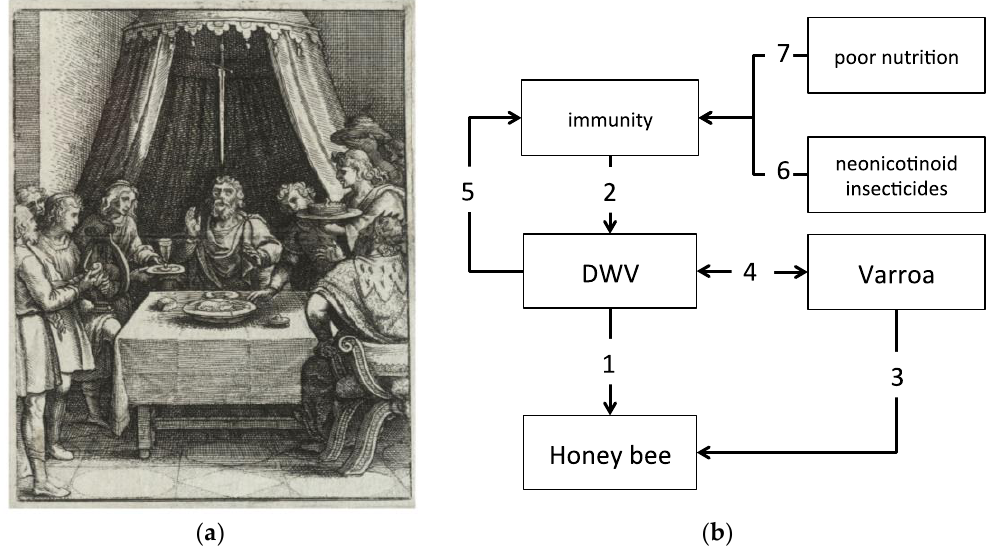
Figure 1. The expression ‘ sword of Damocles ’ denotes the sense of foreboding engendered by a precarious situation, whereby the onset of tragedy is restrained only by a delicate trigger. ( a ) A pictorial representation of the legend that generated the colloquial expression, by Wenceslaus Hollar (1607–1677), where the sword hanging above Damocles neck is depicted; ( b ) Honey bees are permanently threatened by covert DWV infections (1) that are normally kept under control by the bee’s immune system (2); the Varroa mite, which also causes direct damage to bees (3), can trigger viral replication and take advantage (4) of the immune suppression exerted by the virus above a certain threshold (5). Other stressors, such as neonicotinoid insecticides (6) or poor nutrition (7) can interfere with the system by impacting either directly or indirectly honey bee immunity.